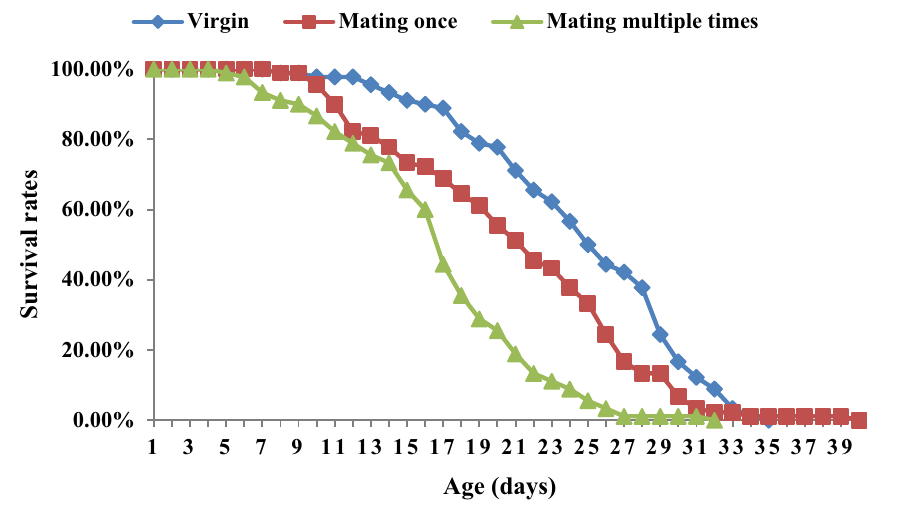
Figure 7. The survival rates of female C. japonicus at different mating times. Data in the figure is mean ± standard error, different letters indicate significant differences in Duncan’s test, with a probability of 5%.